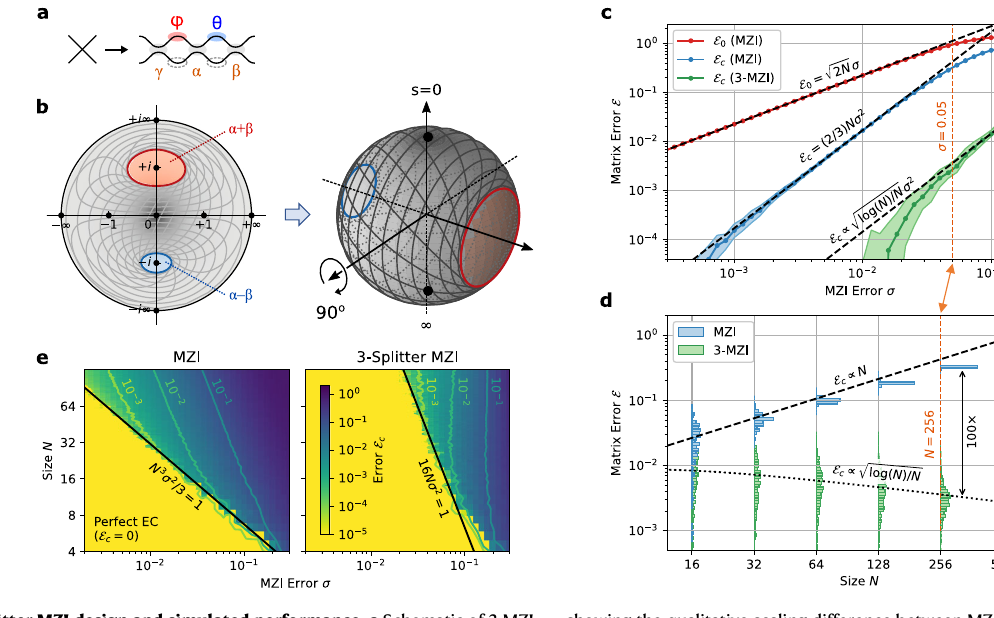
showing the qualitative scaling difference between MZI and 3-MZI ( fi xed splitter variation σ =0.05). e Corrected error E c as function of both σ and N . The sudden onset of "perfect'' hardware error correction ( E c =0) occurs when the coverage approaches unity ( C ≈